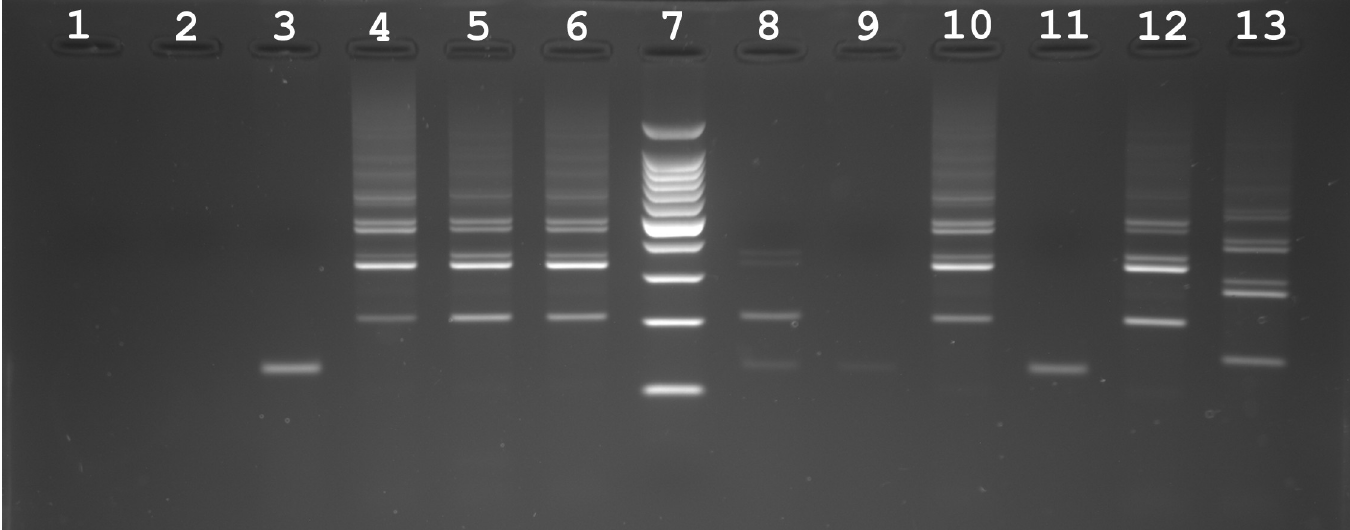
Fig 3. Molecular diagnostic of samples (either worms or biopsies) recovered from non-infected (negative control) and infected rats ( Rattus rattus ) in Corsica, France. The Sh73/DraI PCR specifically targets parasites from the S . haematobium group. The first three wells correspond to PCR results obtained for biopsies from the liver (well 1), mesenteric vessels (well 2) and bladder (well 3) of a non-infected rat (R3). The following three wells correspond to PCR results obtained from an adult worm (well 4), a mesenteric biopsy (well 5) and a biopsy on a liver granulum (well 6) from the infected rat R1. Well 7 is a size standard (ladder). Well 8–9 are PCR amplifications obtained from a biopsies of the mesenteric vessels (well 8) and of the hepatic portal system (well 9) collected on the infected rat R2. Well 11: negative control. Well 10, 12 and 13 are positive controls (well 10: worm of the corsican schistosome strain, well 12: DNA from pure S . haematobium worm and well 13: DNA from pure S . bovis worm). Note that all of the amplification patterns obtained on the infected rats display a classical S . haematobium pattern.